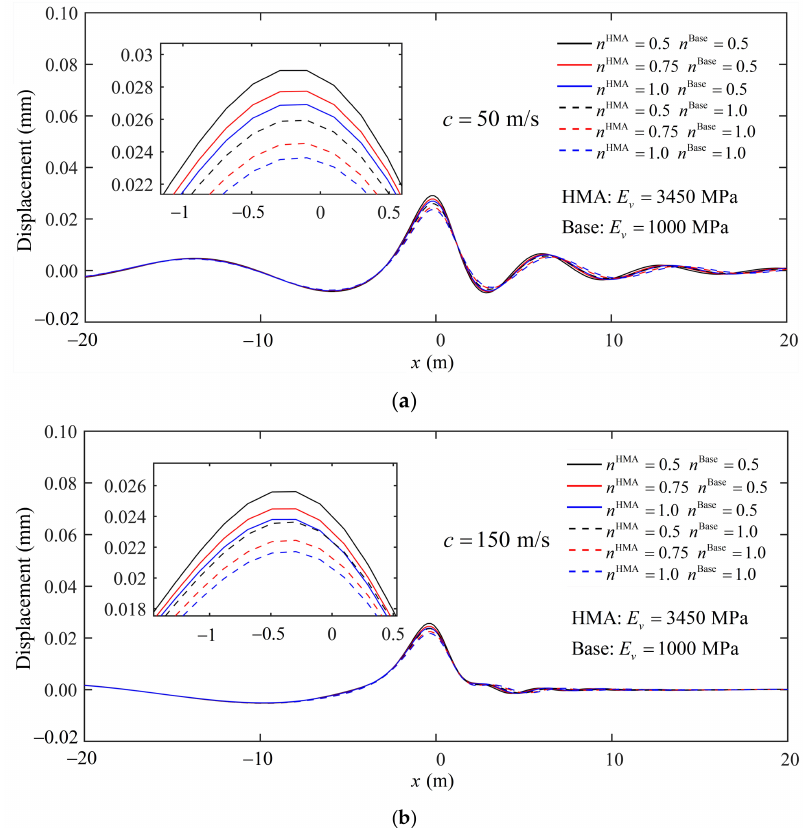
Figure 15. Effect of the layer modulus ratio, n = E h / E v , with a fixed vertical modulus on the vertical displacement fluctuation amplitude along the x -axis, induced by a moving Gaussian load, with speeds of ( a ) c = 50 m/s and ( b ) c = 150 m/s.